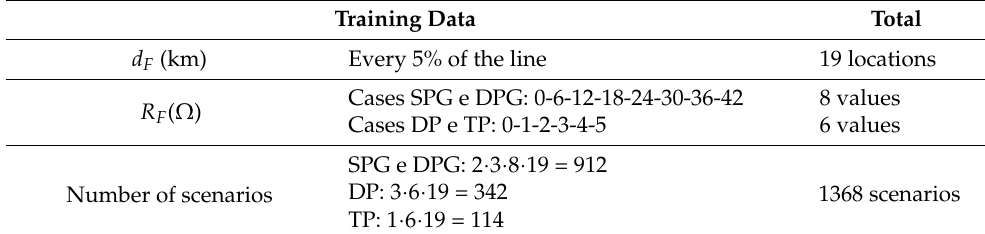
Table 4. Composition of fault scenarios: Training of